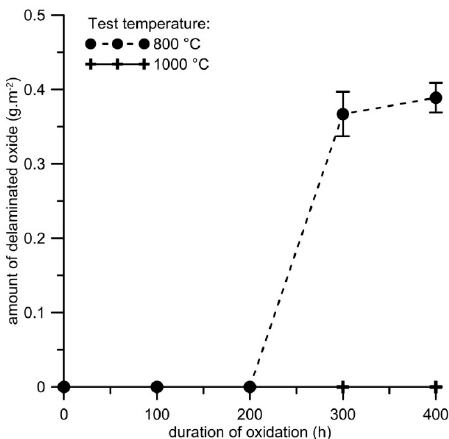
Figure 6. Dependence of the amount of delaminated oxide (g 006 − 2 ) on the duration of isothermal oxidation at 800 and 1000 °C in air for FeAl20Si20 alloy.